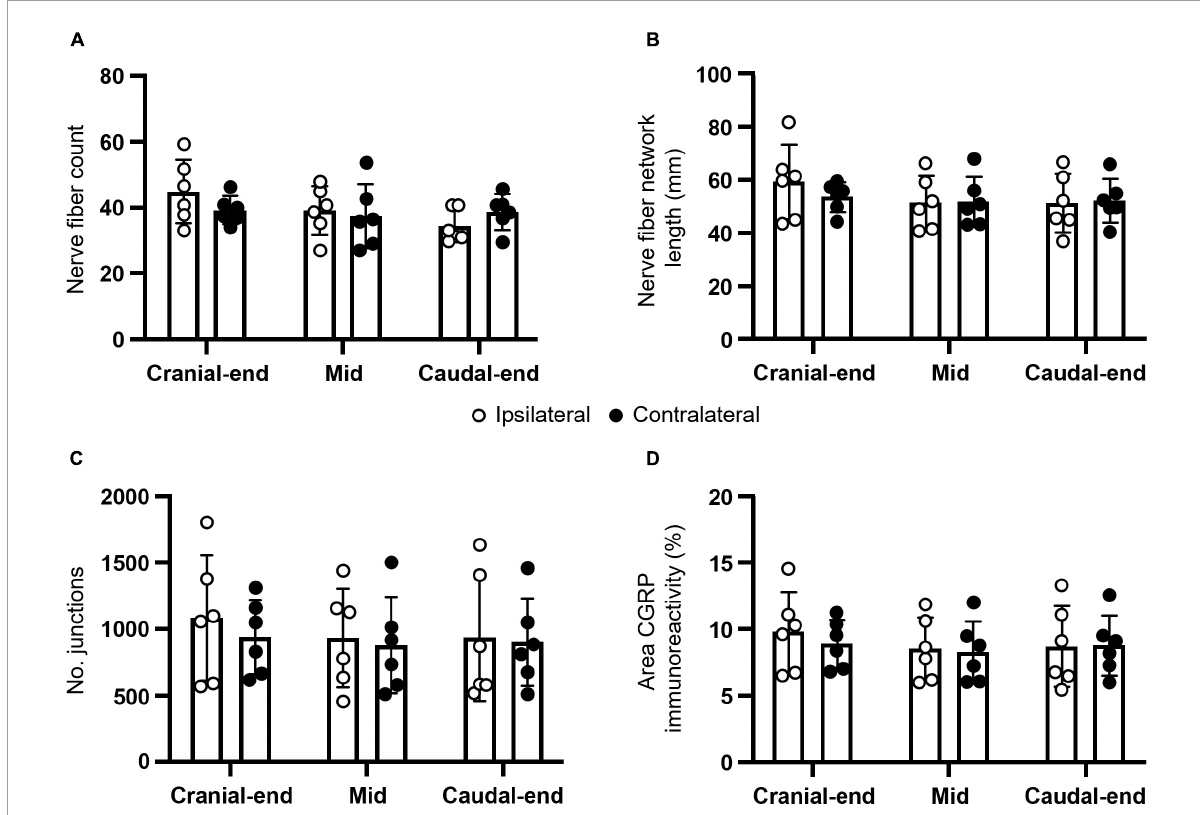
FIGURE2 Anatomical characteristics of CGRP-expressing nerve fibers in the mouse uterine horn following unilateral lumbosacral L5-S1 DRG removal. Summary data of (A) nerve fiber counts; (B) nerve fiber network lengths; (C) number of junctions; and (D) proportion of area containing CGRP immunoreactivity. No statistically significant differences were observed between ipsilateral and contralateral uterine horns from DRG-removed animals for all measures ( N = 6 per group). All panels were analyzed using two-way, repeated measures ANOVA with Šídák’s multiple comparisons. CGRP, calcitonin gene-related peptide; DRG, dorsal root